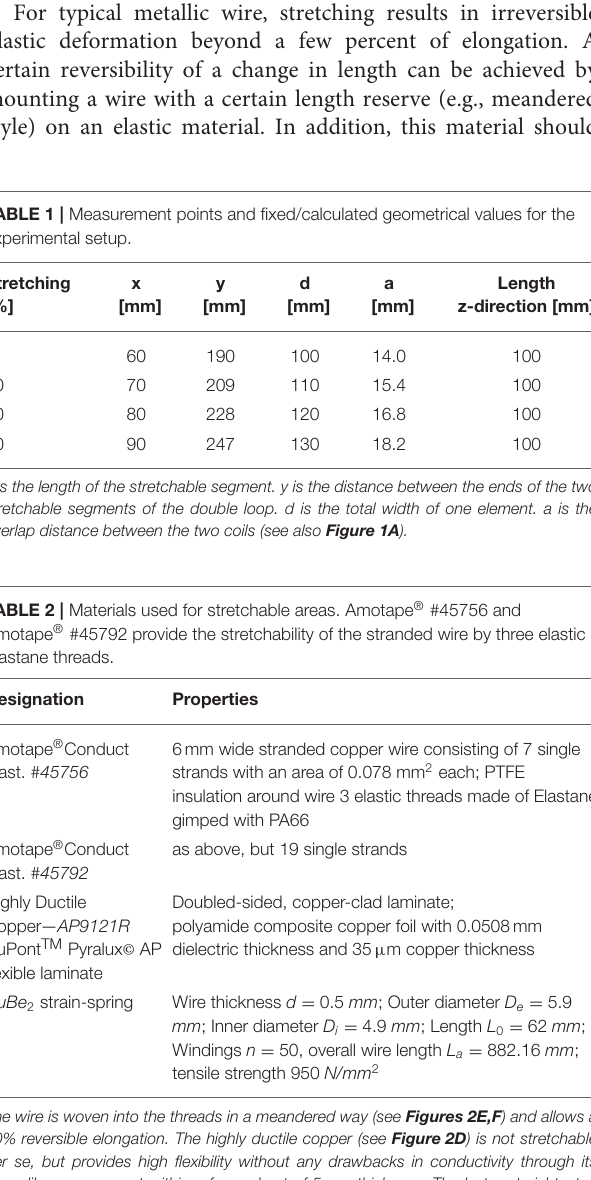
TABLE 1 | Measurement points and fixed/calculated geometrical values for the experimental setup.